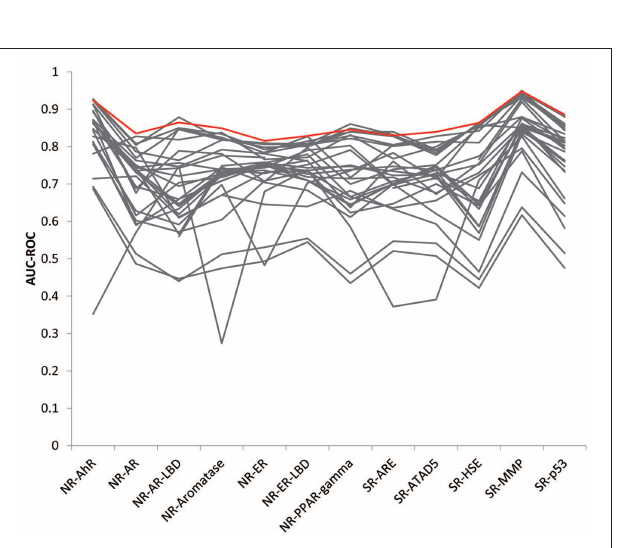
FIGURE 4 | Wisdom of the crowd. The best consensus models (colored in red) outperformed 96% of the individual models (colored in gray) on average and half of the winning